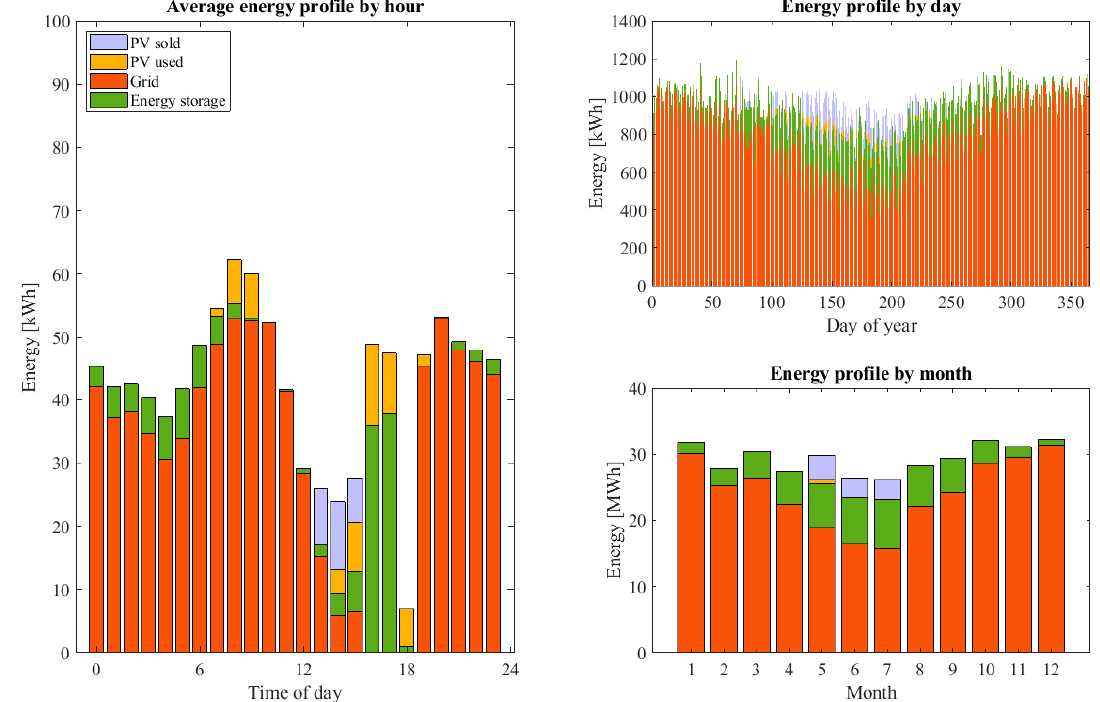
Figure 16. Average energy profiles by hour, day, and month in scenario 3.b. Compared to previous scenarios, less than 2% of the cars leave the house without being fully charged. However, the mean SOC of not-full charged vehicles at departure is about 96%, with a minimum SOC of about 85% for one customer during one year. That can be considered fairly negligible or could be eliminated by increasing the minimum grid use to a slightly higher threshold. The annual grid usage is calculated to be 292 MWh, which is double what was consumed in scenario 3.a with only 8 cars charging per day.